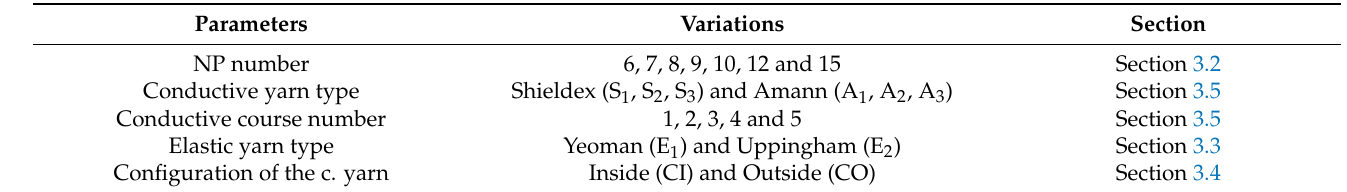
Figure 1. ( a ) Co-knitted 1 × 1 rib structure with two conductive yarn courses: (indicated in black) and non-conductive yarns (white), and ( b ) A yarn carrier containing two parallel yarns. Knitted strain sensors were prepared with the parameters listed in Table 2. The conductive course number was varied between 1 to 5, and knit densities were varied by selecting NP numbers between 6 to 15. The NP value is related to the needle pitch distance. The position of the conductive yarn is referred to as conductive outside (CO) and conductive inside (CI), respectively. This will be discussed in detail later (see Figure S2). Table 2. Parameters of knitted strain sensors tested in the study and the section in which they are